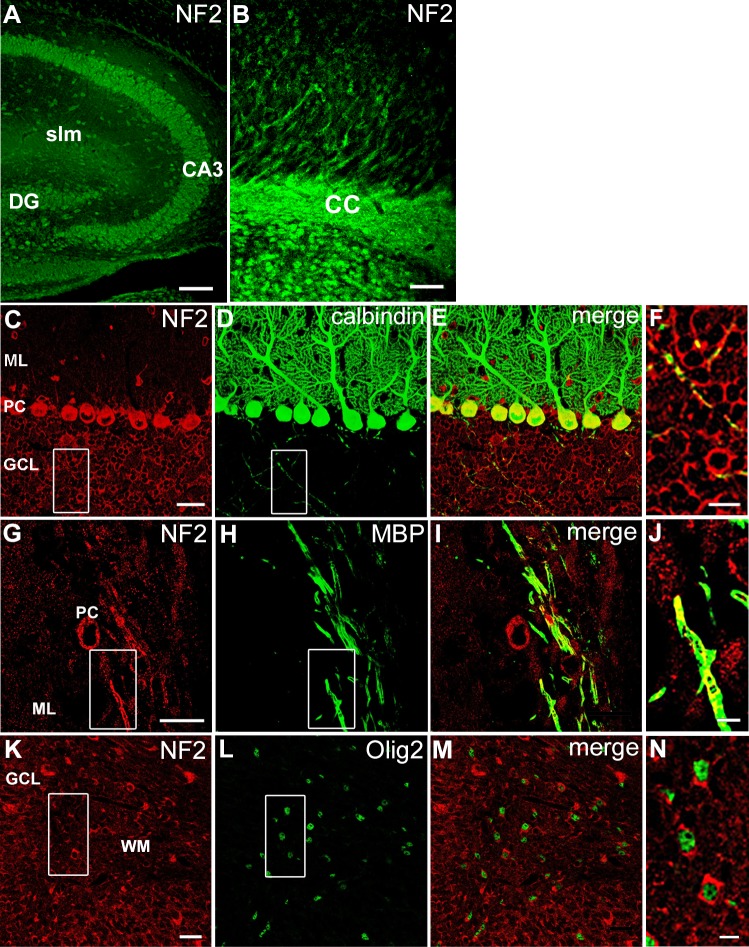
Expression of Merlin in oligodendrocytes of the forebrain and cerebellum.Merlin is present in neuron enriched areas of the hippocampus (dentate gyrus DG and corpus ammonis CA3), but also in the stratum lacunosum moleculare (slm) of the hippocampus (A) and the corpus callosum (cc) of the cortex cerebri (B) of adult mice. Merlin is localized in close approximation to Calbindin (C-F) and MBP (G-J); high magnifications in F, J demonstrate the presence of NF2 in neurons and oligodendroglia. NF2 staining is also present in a subset of Olig2-positive cells of cerebella of nine day-old mice (K-N). Abbreviations: DG: dentate gyrus, cc: corpus callosum, GCL: granule cell layer, ML: molecular layer, PC: Purkinje cells, slm: stratum lacunosum moleculare, WM: white matter. Scale bars: (A) 1000 μm, (B) 25 μm, (C-E, G-I, K-M) 25 μm, (F, N) 10 μm, (J) 5 μm.